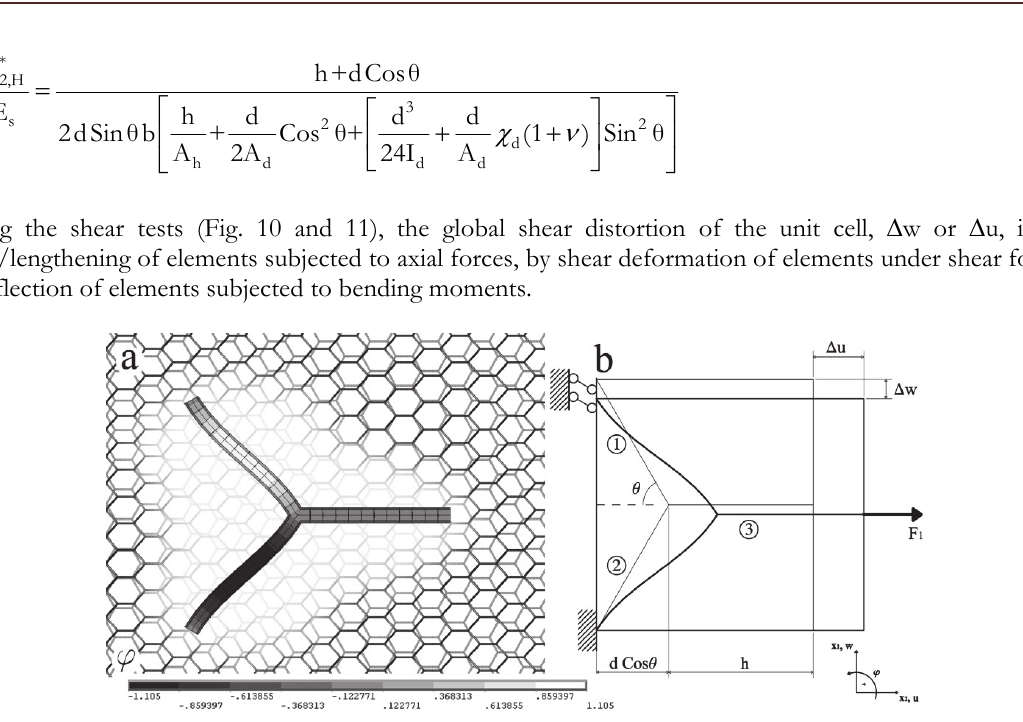
Figure 9: Hexagrid - axial test along x 2 ; a) deformed configuration; b) definition of the RVE.